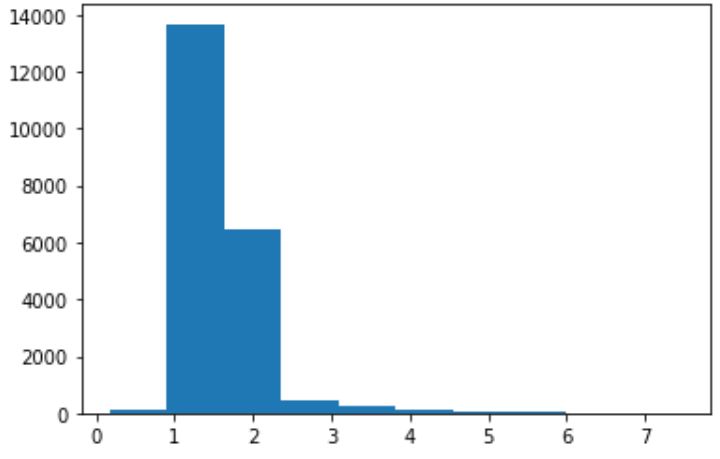
Figure 5: Distribution of walkability values calculated from walking trails in the study area.